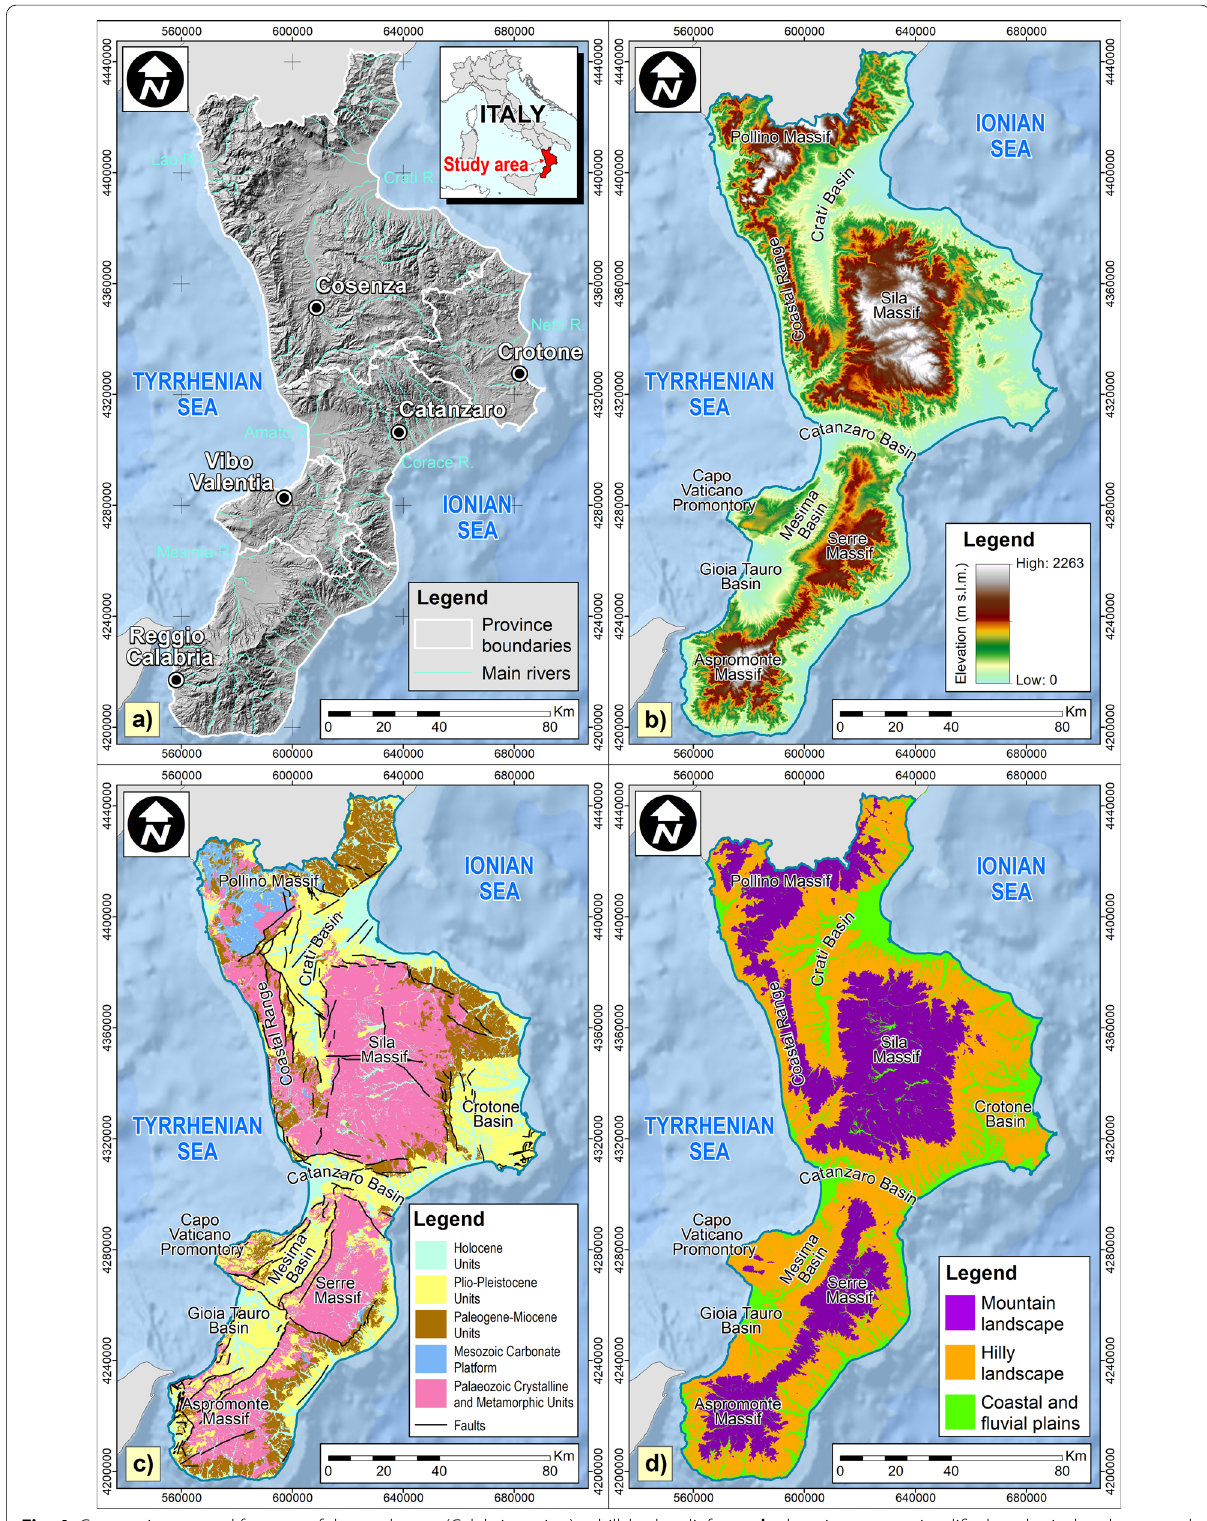
Fig. 4 Geo-environmental features of the study area (Calabria region): a hillshade relief map; b elevation map; c simplified geological and structural map (modified after Borrelli et al. 2021); d map of physiographic